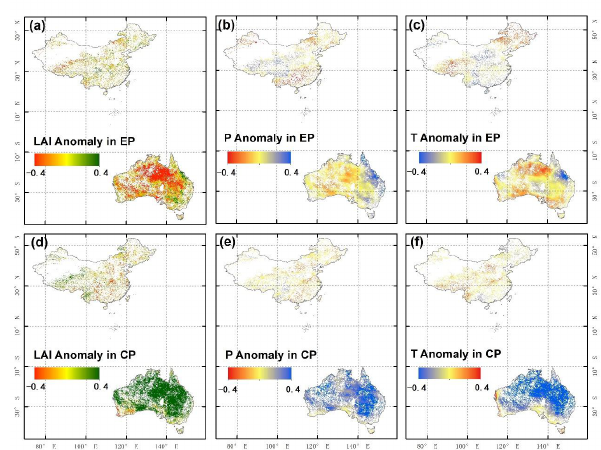
Figure 4. Multi-year average vegetation (LAI), precipitation (P), and temperature (T) anomalies during La Niña events for China and Australia. (a)-(c) Mean anomalies during EP La Niña events; (d)-(f) Mean anomalies during CP La Niña events.